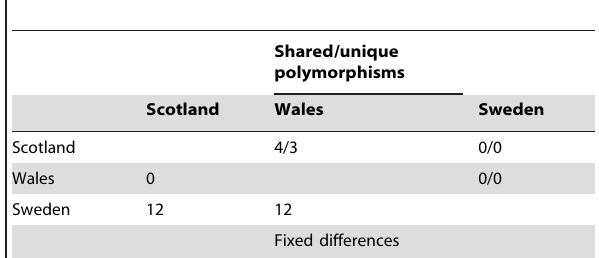
Table 5. Pairwise comparisons of RPB1 sequences between N. granulosis isolates, showing frequency of shared polymorphisms, unique polymorphisms and fixed differences.